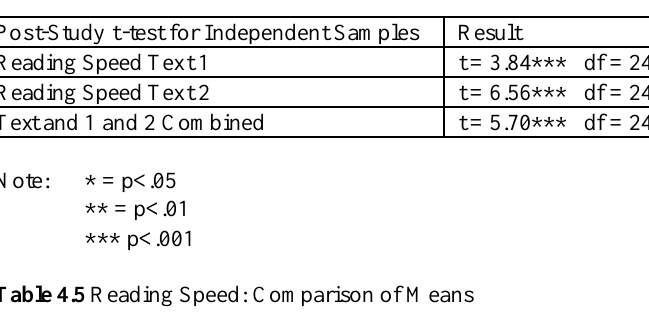
Table 4.4 Reading Speed – Analysis of Gains